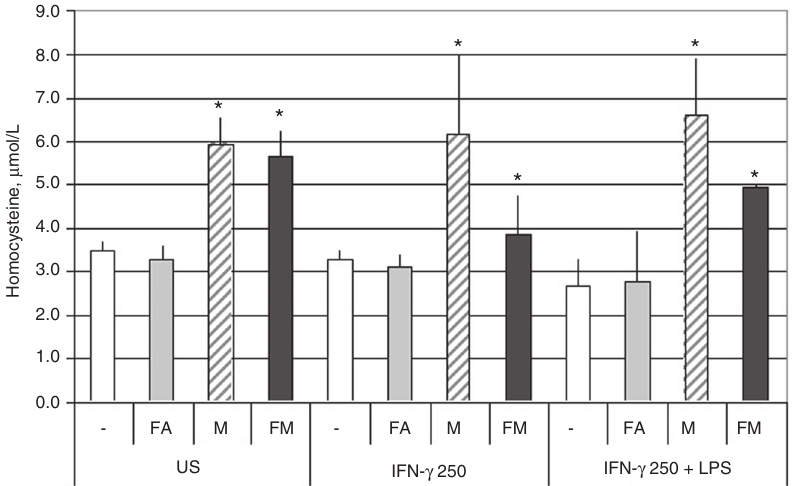
Figure 2 Homocysteine concentrations measured in the supernatants of unstimulated (US) and stimulated myelomonocytic cells (THP-1) (IFN- γ 250 = IFN- γ 250 U/mL) that were supplemented with folic acid (FA), methionine (M) and the combination of both compounds (FM). Significant differences are indicated by an asterisk (*p <